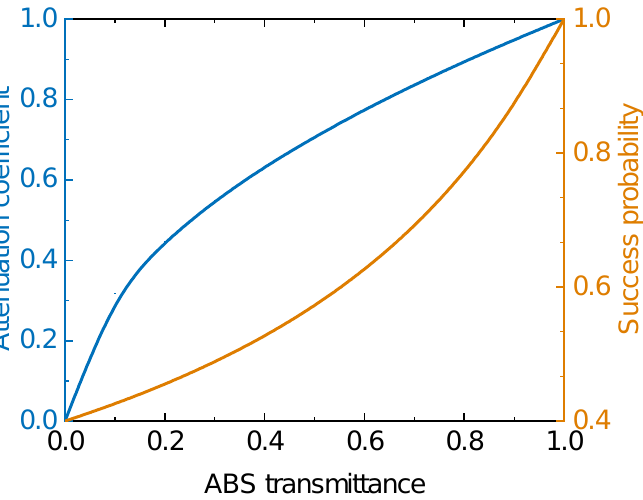
Figure 4. The attenuation coefficient vs. transmittance and the corresponding success